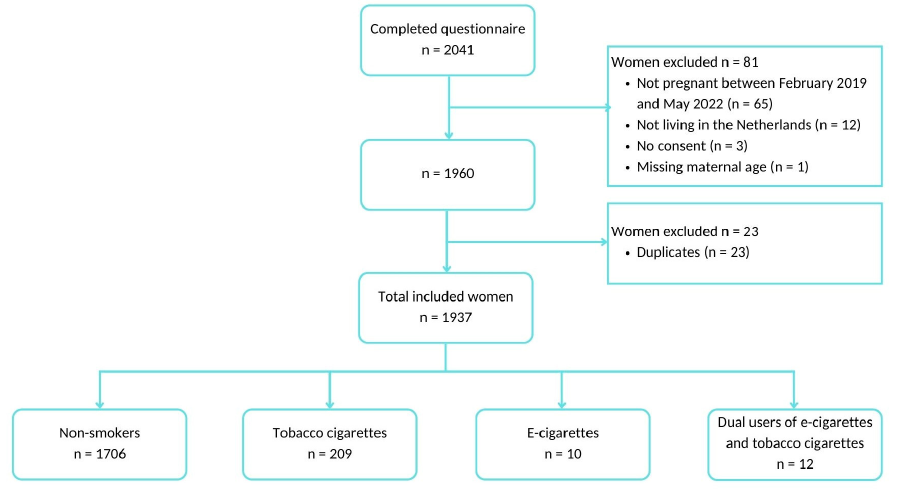
Figure 1. flowchart of the included population. Figure 1. Flowchart of the included population. Table 1 summarizes the demographic and lifestyle characteristics by smoking status. Of